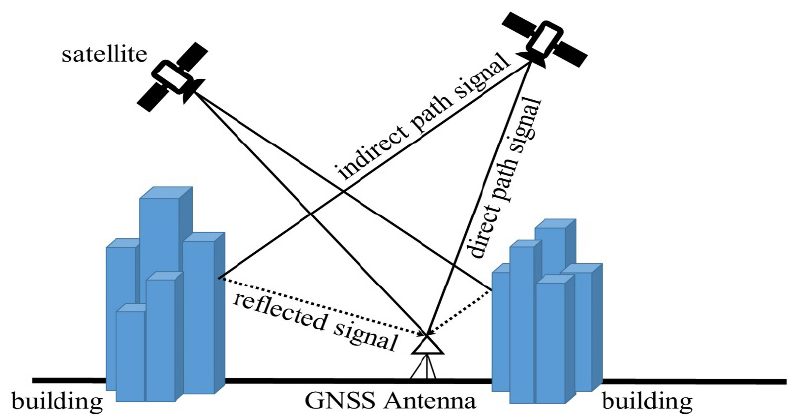
Figure 1. Example of outdoor multipath interference.